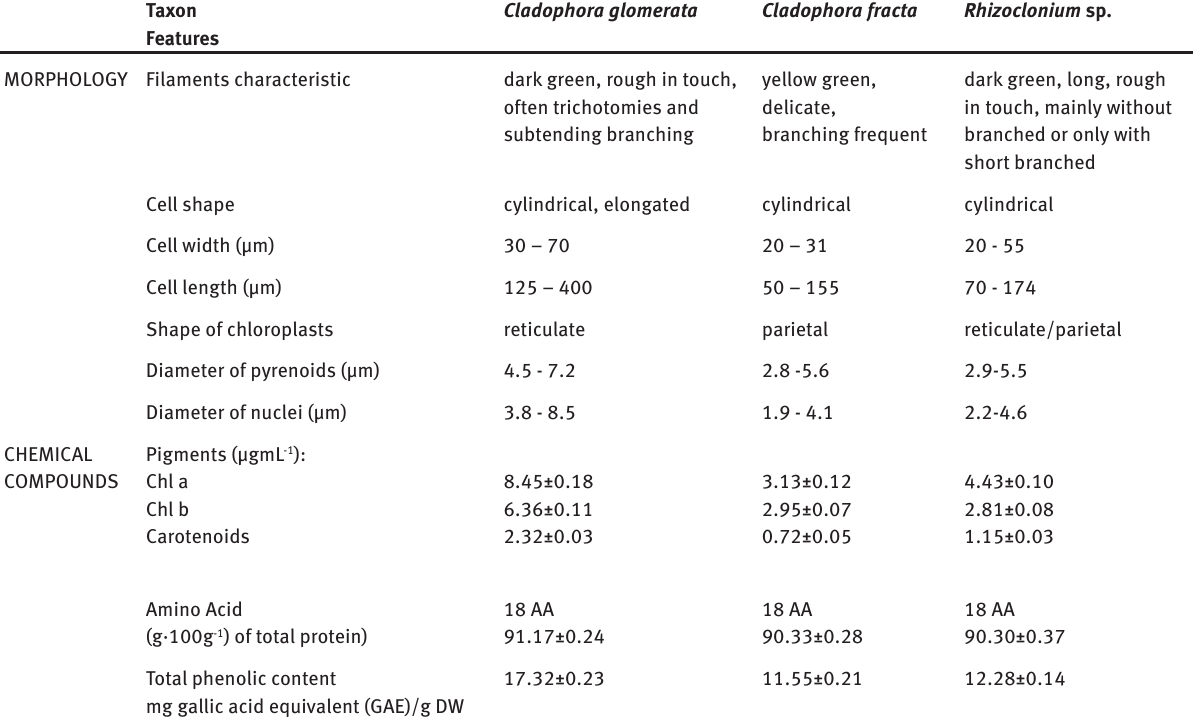
Figure 1: Details of the ultrastructure of Cladophora glomerata thalli: a – general view of branched filaments (LM); b - surface of filament inhabited by periphytic diatoms (SEM); c – TEM micrograph of mitochondrion (M) in the vicinity of chloroplast (Chl) and pyrenoid (P) surrounded by chloroplast; the arrangement of thylakoids (Th) in chloroplast; internal singular vacuole (V) well organized; d – cell wall (CW), external layer and internal division of two cells; lipids on the chloroplast (Chl); (c, d – scale bar = 0.5 µm). Table 1: Morphology and chemical characteristic of freshwater green algae (values: minimum – maximum or mean±SD, n=30 for morphology data, n=3 for chemical